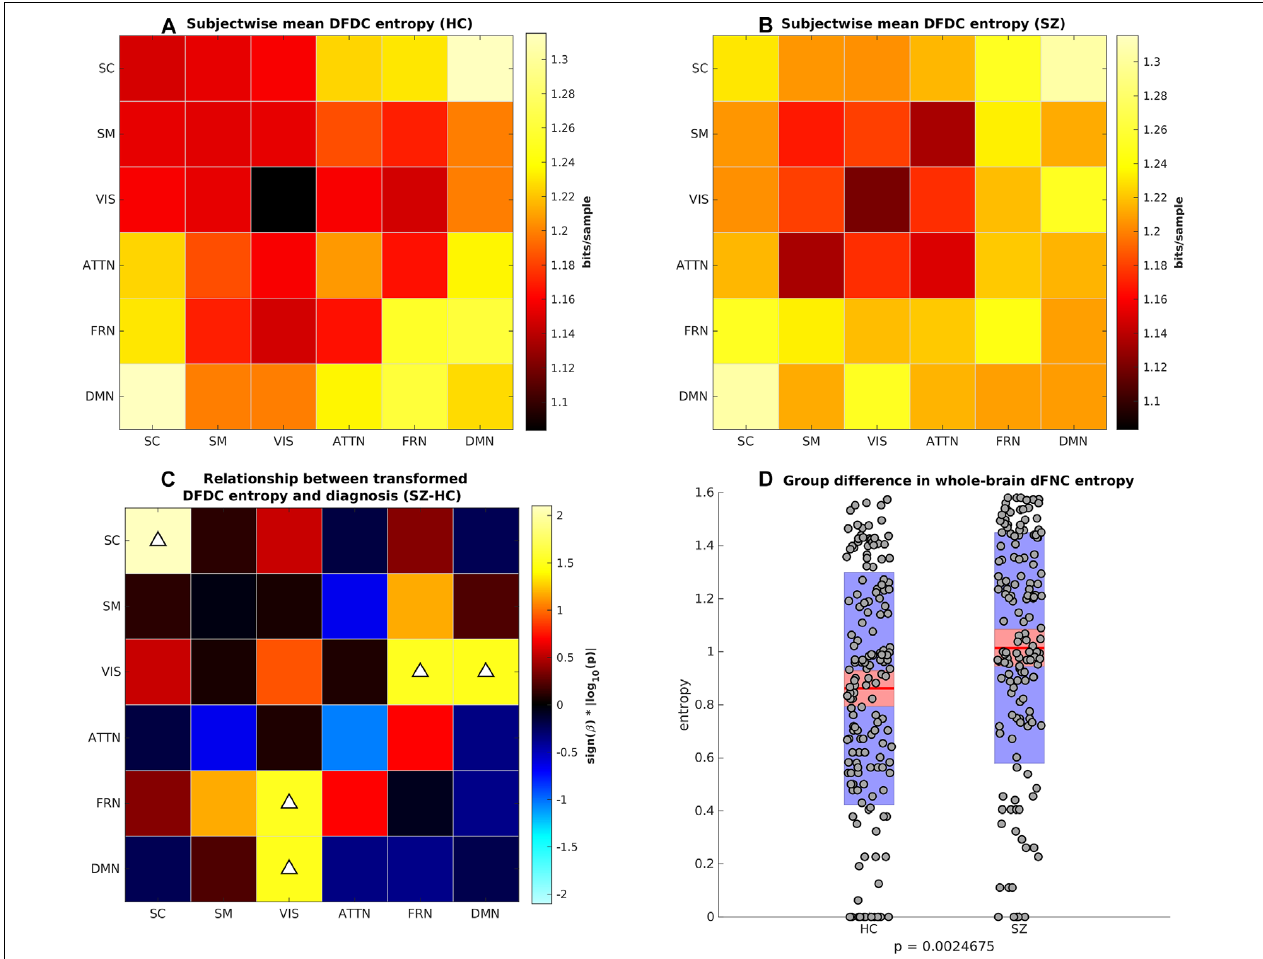
FIGURE 4 | (A) Subject-wise mean entropy for HCs, (B) subject-wise mean entropy for SZs, (C) group difference results from regressing diagnosis on subject-wise entropy. The color intensity indicates sign ( β ) × | log10 ( p ) | where β is the coefficient of regression and p is the p -value corresponding to the t -statistic of the coefficient. Upward arrows on the positive quantities indicate SZs have significantly higher entropy than HCs ( p < 0.05, uncorrected). (D) Boxplots showing whole-brain dFNC entropy in HC vs. SZ. SZs have significantly higher dFNC entropy than HCs.